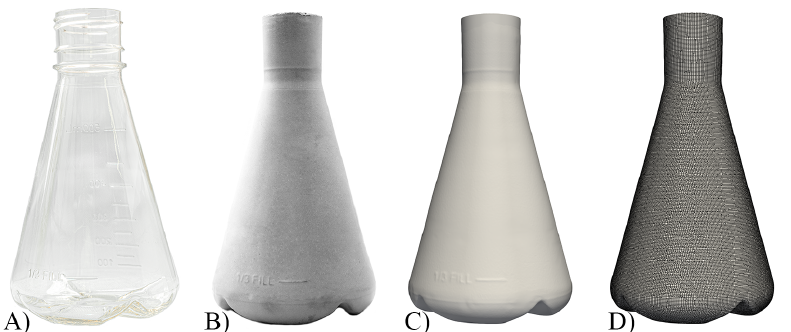
Figure 2. Process steps from the single-use shake flasks to computational mesh. ( A ) The 500mL baffled shake flask. ( B ) Model cast with levelling compound. ( C ) Scanned and smoothed computer model. ( D ) Computational mesh used for the CFD